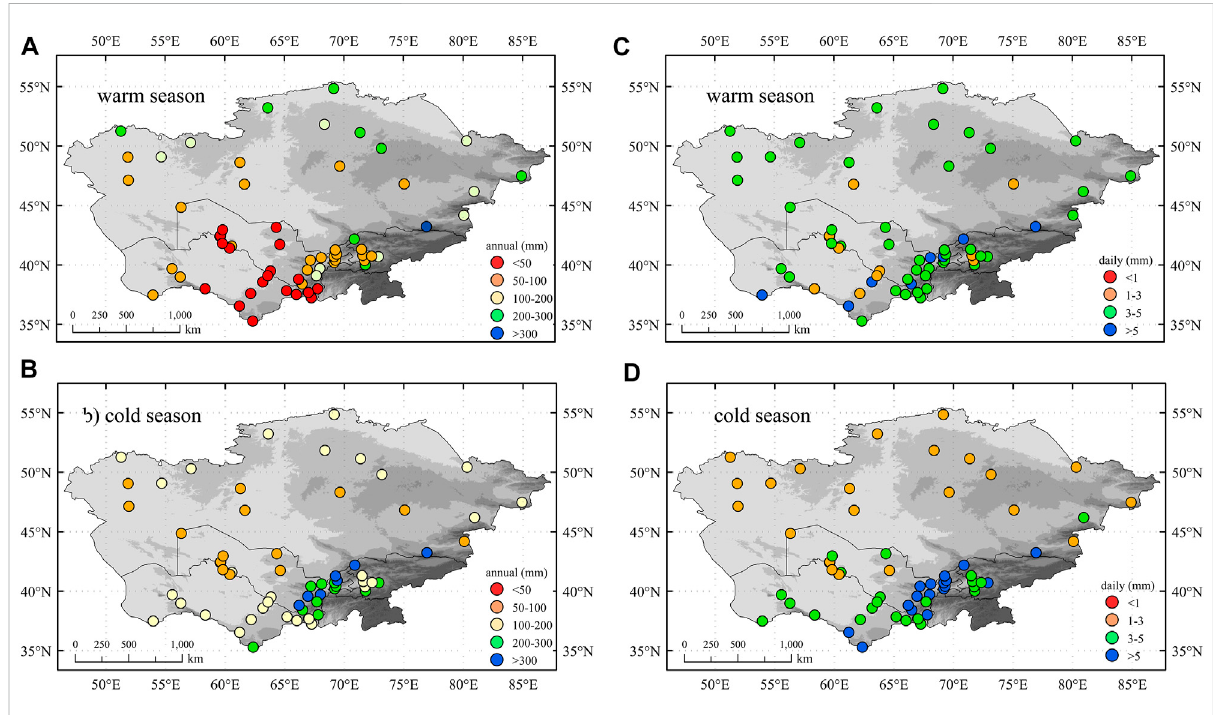
FIGURE 2 Spatial distribution of annual mean precipitation (A,B) and wet-day mean precipitation (C,D) in warm and cold season over Central